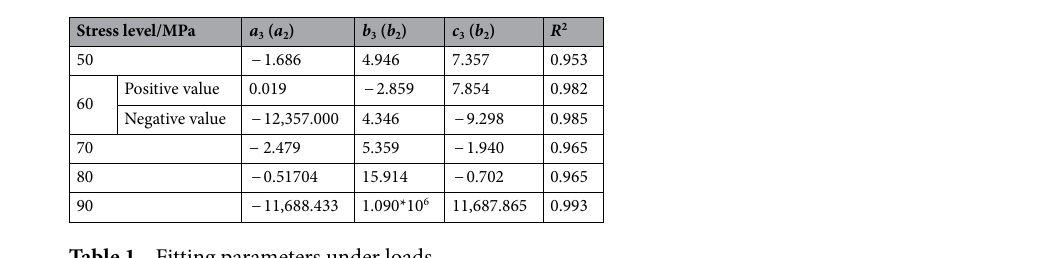
Table 1. Fitting parameters under